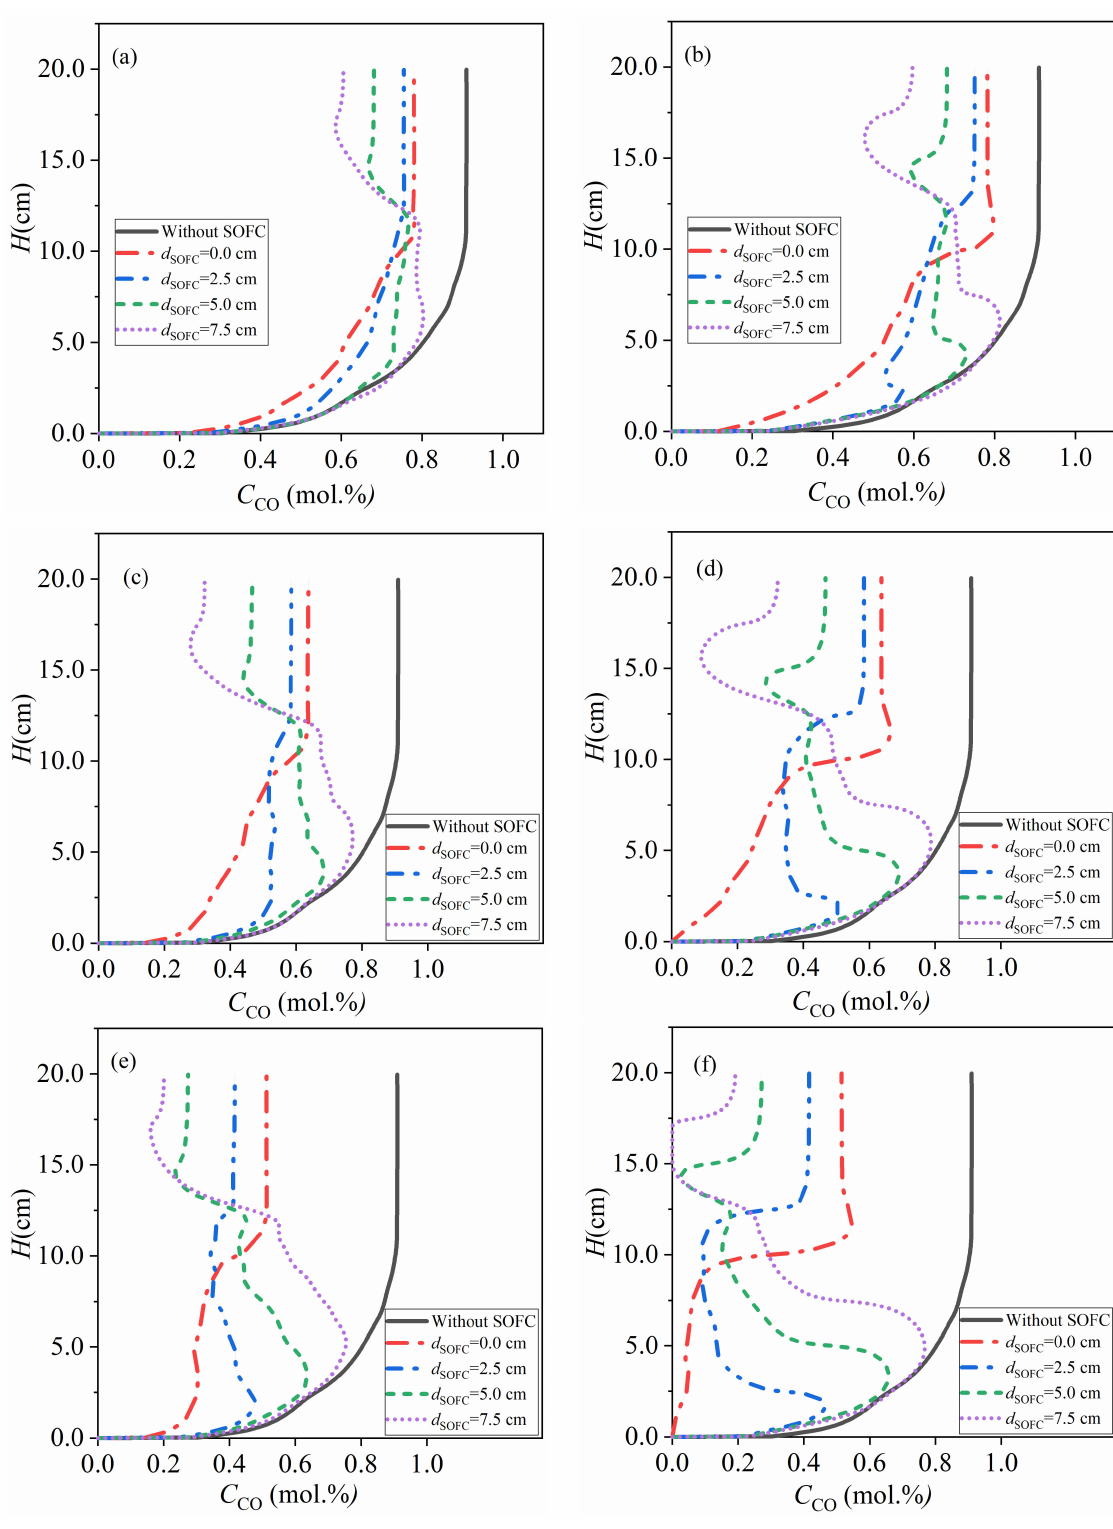
Figure 13. Averaged CO molar fractions ( a , c , e ) and CO molar fractions near side walls ( b , d , f ) along channel for bubbling bed gasifiers coupled with SOFC with A s = 7.2 × 10 − 5 mol/m 2 , v CO ( e , f ) 15,000 A/m 2